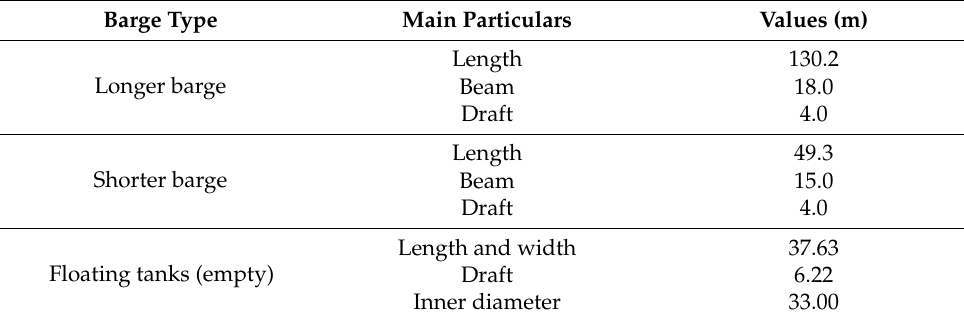
Figure 2. Definition of the global coordinate system and free surface point of interest: ( a ) cross-section, ( b ) plan view, ( c ) location of the monitored free surface point. Table 1. Main particulars of the barge components and floating tanks.